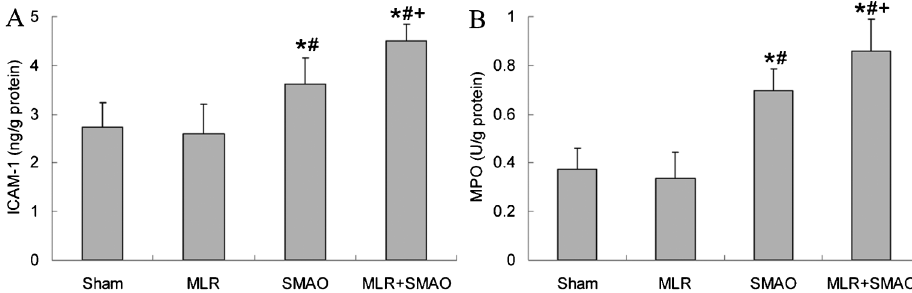
Figure 5. Effect of mesenteric lymph reperfusion (MLR) on the indices related to adhesion and recruitment of polymorphonuclear neutrophils in splenic homogenate of rats with superior mesenteric artery occlusion (SMAO) shock. Data are reported as means±SD, n=6. A , Intercellular adhesion molecule-1 (ICAM-1) level. B , Myeloperoxidase (MPO) activity. *P , 0.05 vs sham group; # P , 0.05 vs MLR group; + P , 0.05 vs SMAO group (one-way